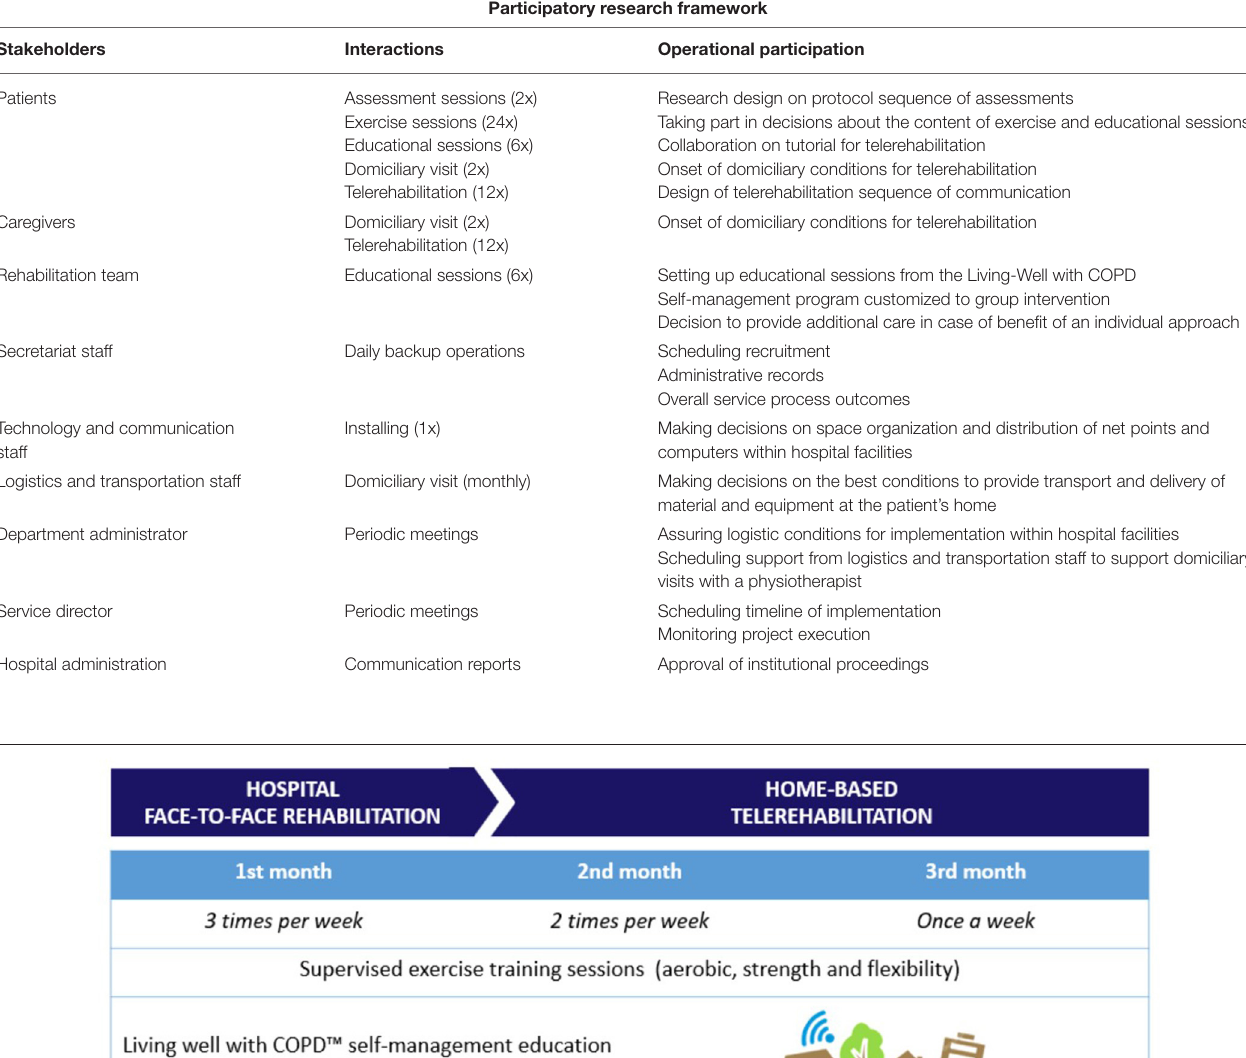
TABLE 1 | Participatory research framework.